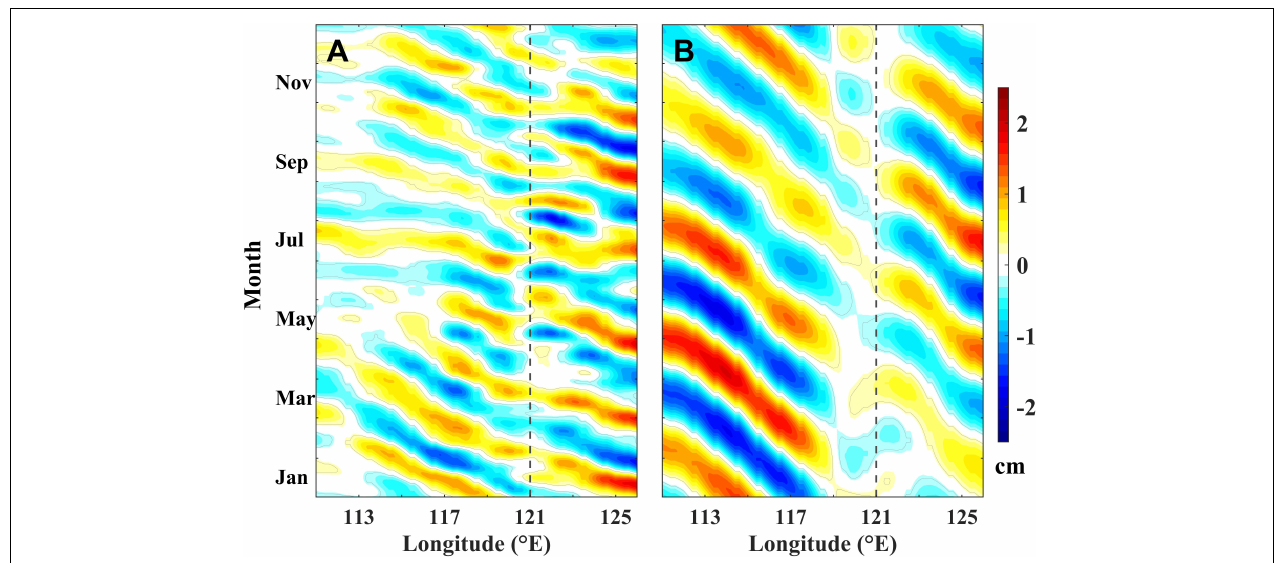
FIGURE 9 | Hovmöller diagrams of annual mean sea level anomaly (cm) of two periods along with the black box of Figure 8 . (A) 10–65-day period; (B) 65–110-day period. Black dashed lines: central Luzon